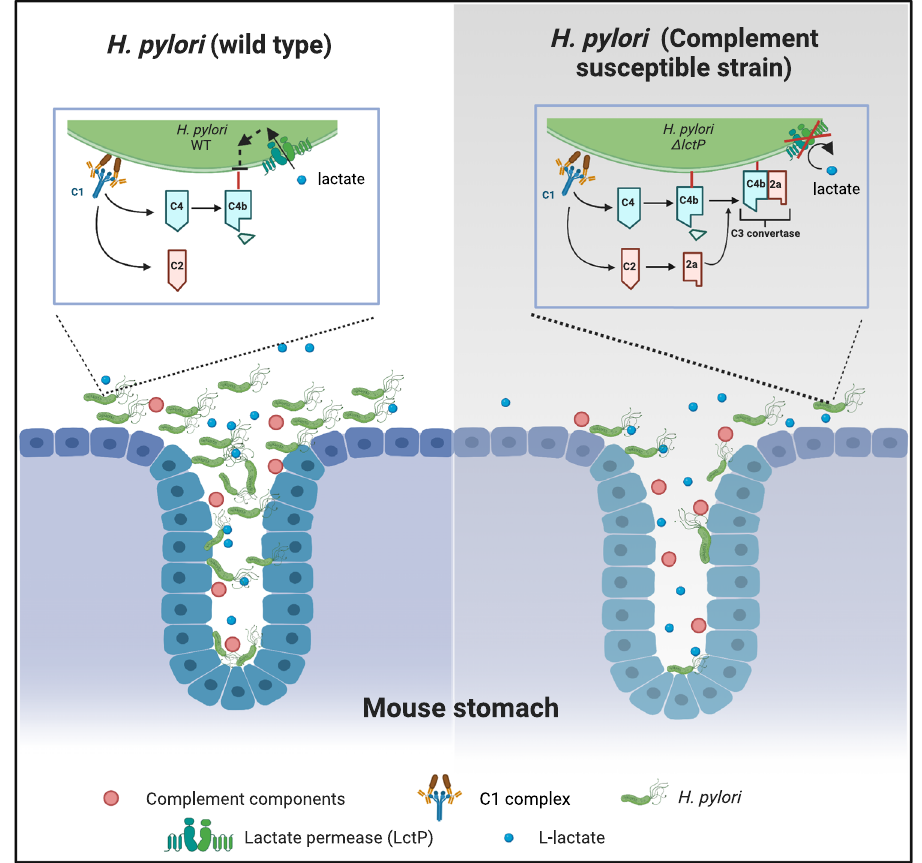
Fig. 6 | Proposed model for L-lactate promotion of H. pylori gastric coloniza- tion. Model showing how complement may operate in the stomach to inhibit H. pylori colonization. The left panel shows WT H. pylori , which is able to colonize thegastricmucosalsurfaceandglandsinthefaceofcomplement(redcircles).The insetdetailshowL-lactate(bluecircles)uptakeinto H.pylori blocksthestepofC4b surface deposition, rendering H. pylori complement resistant. This mechanism of